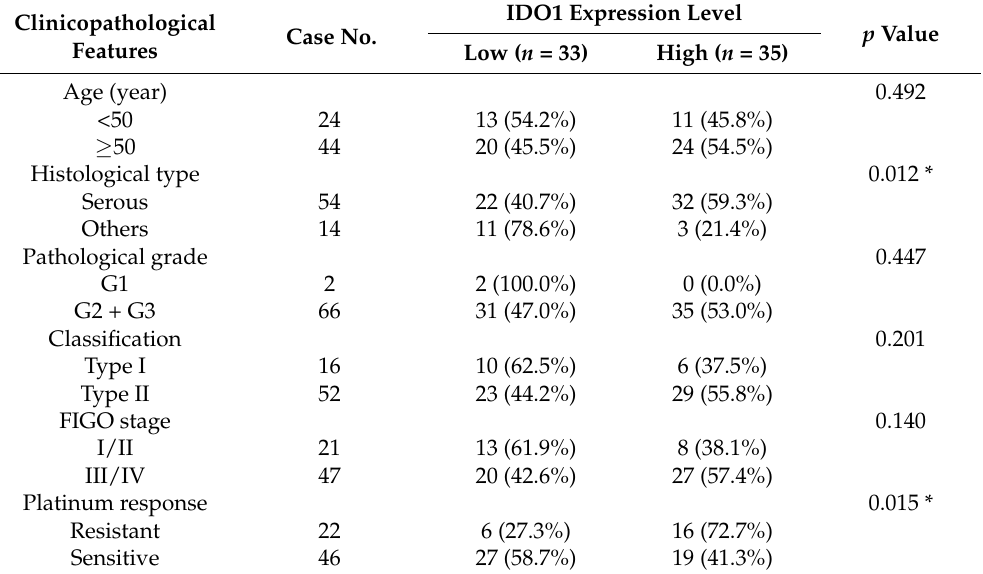
FIGO: International Federation of Gynecology and Obstetrics; *: p <